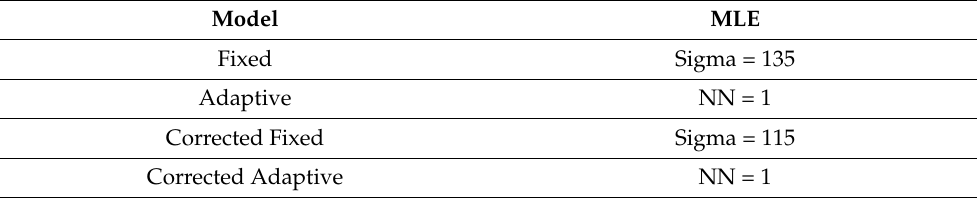
Table 2. MLE of the